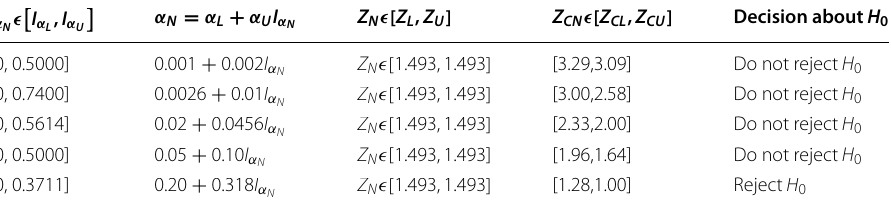
Table 4 Effect of level of significance in